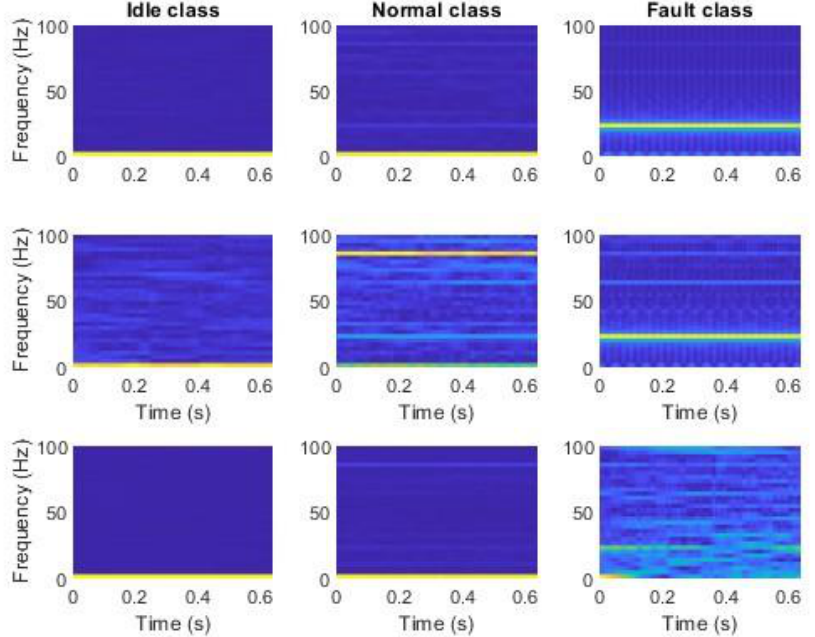
Figure 13. Accelerometer data in the time–frequency domain using mSDFT in the 3-axis: top row, Z , middle row, Y , bottom row— X .